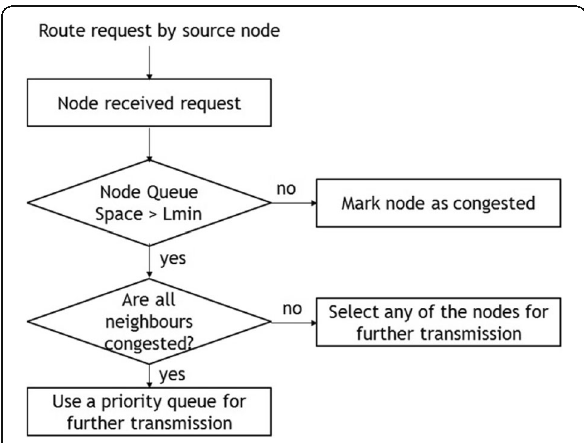
Algorithm for node sorting based on queue space: if Q > L space